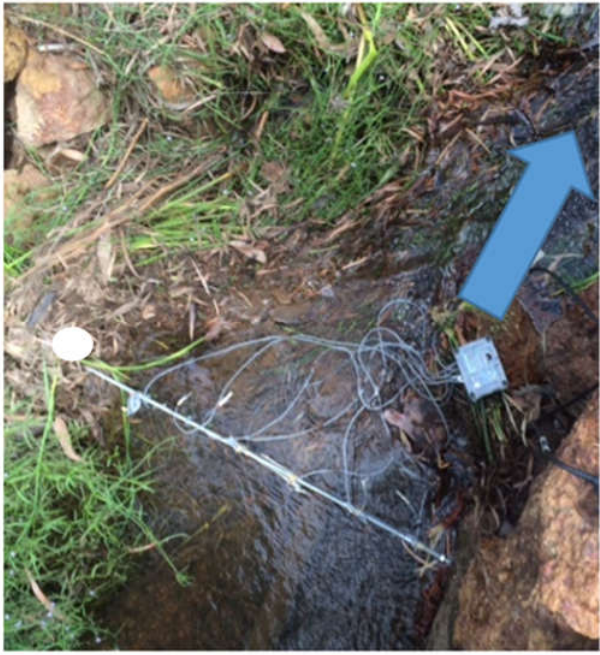
Figure 3. Photograph of measured channel section for Neerigen Brook Reach 1. Arrow pointing downstream. (picture: K. Smettem)